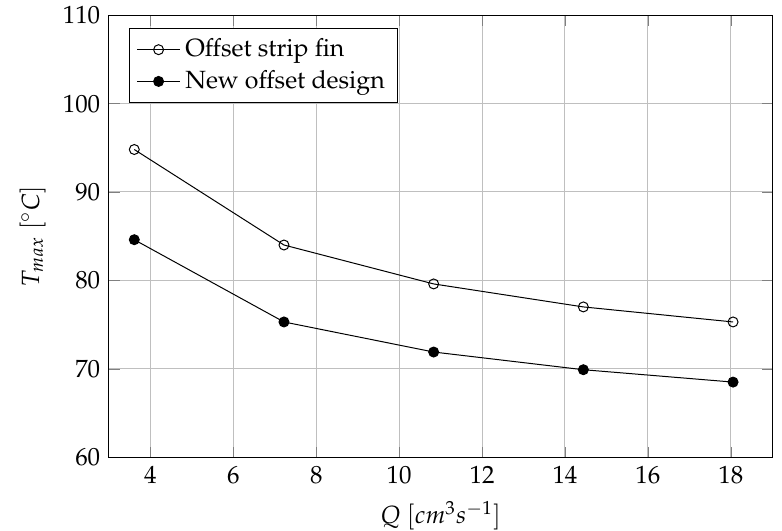
Figure 11. Maximum chip temperature ( T max ) in different volumetric flow rates for conventional offset strip fin design and new offset